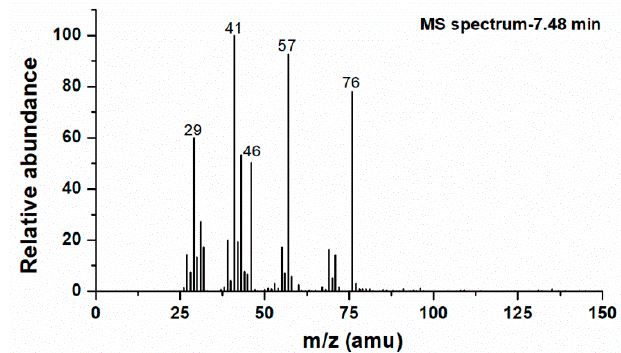
Figure 2. Mass spectra (MS) corresponding to the chromatographic peak at 7.48 min.